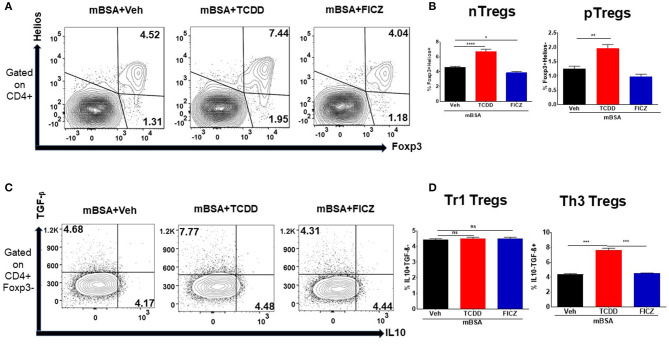
Effect of TCDD on Treg subsets. DTH was induced as described in Figure 1 legend and Treg subsets were studied using DLN cells and flow cytometric analysis for various markers. (A) Representative flow cytometry dot plots gated on CD4+ cells, displaying the percentage of natural Tregs (nTreg) present through co-expression of CD4, FoxP3, and Helios and the percentage of peripheral Tregs (pTreg) that are CD4+ and FoxP3+, and Helios-. (B) Percentage of (nTregs and pTregs) cells based on groups of 5 mice. (C) Representative flow cytometry dot plots gated on CD4+Foxp3- cells, displaying the percentage of Tr1 Tregs present through co-expression of CD4+Foxp3-IL-10+ and the percentage of Th3 Tregs that are CD4+Foxp3-TGF-β+. (D) Percentage of Tr1 and Th3 Tregs cells based on groups of 5 mice. Vertical bars represent Mean ± SEM and significant difference between groups were indicated by asterisks (*p < 0.05, **p < 0.01, ***p < 0.001, ****p < 0.0001) based on one-way ANOVA.